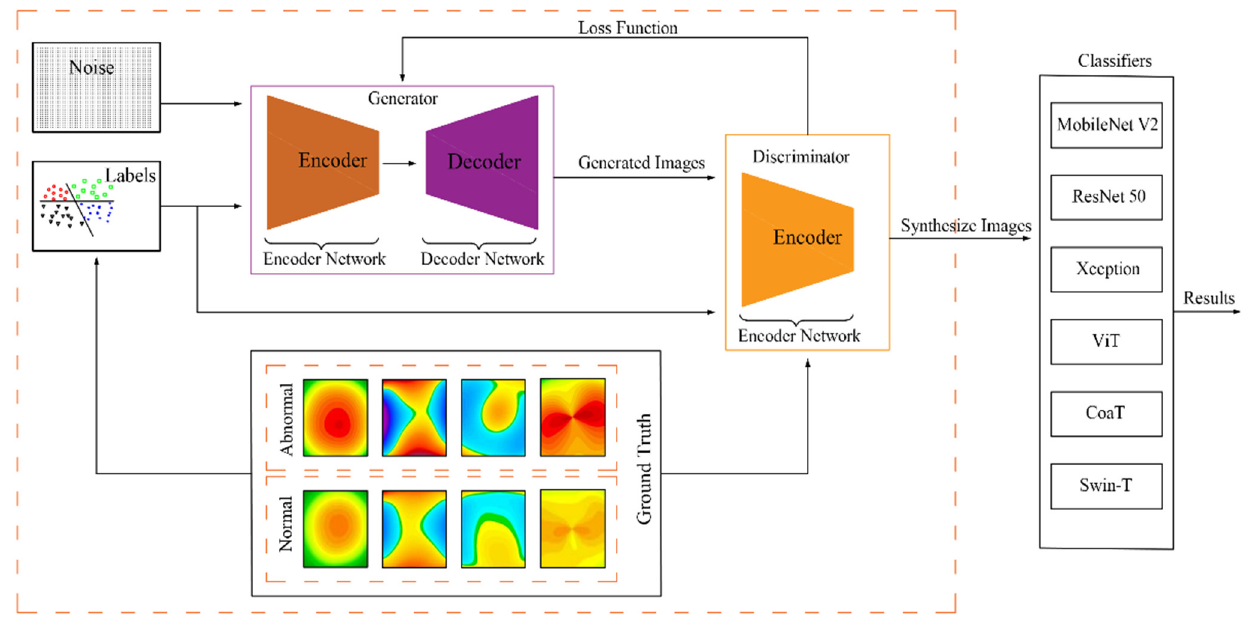
Figure 2. Structure of the proposed system.